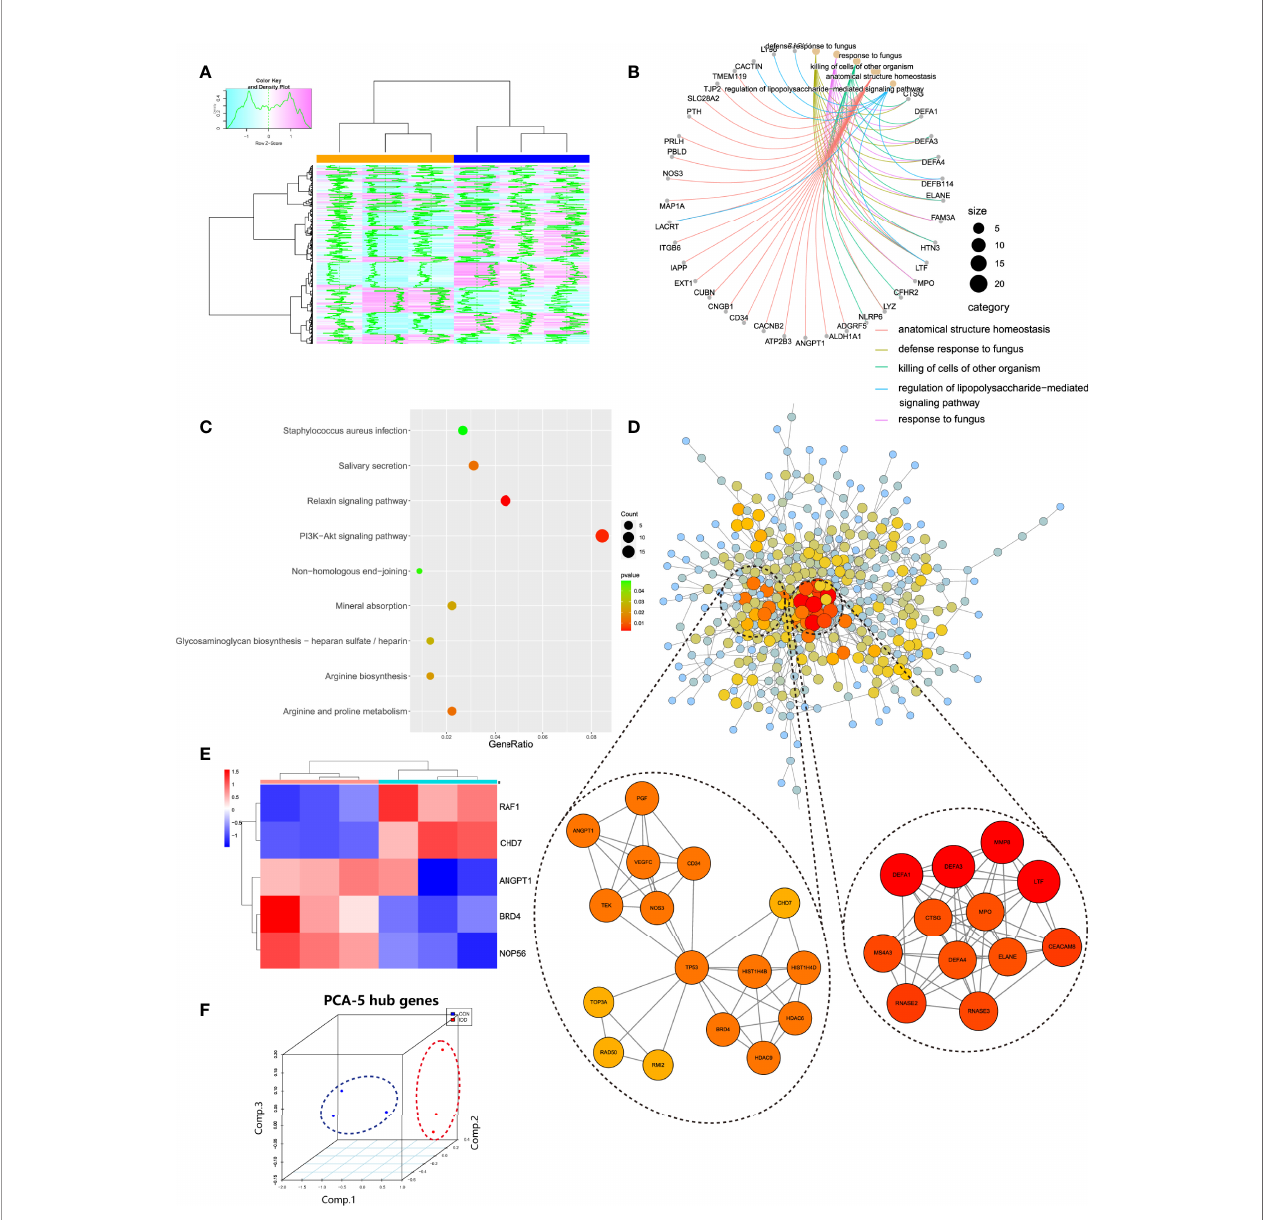
FIGURE 3 | (A) , Pink module genes expression heatmap among normal and DDD groups. (B, C) , Functional and pathways enrichment analysis of pink module. (D) , Construction of PPI network based on genes in pink module, and the top 2 related sub-networks by MCODE algorithm. (E) , Hub genes expression heatmap identi fi ed in pink module. (F) , 3D scatter plot after reducing dimension of hub genes by PCA